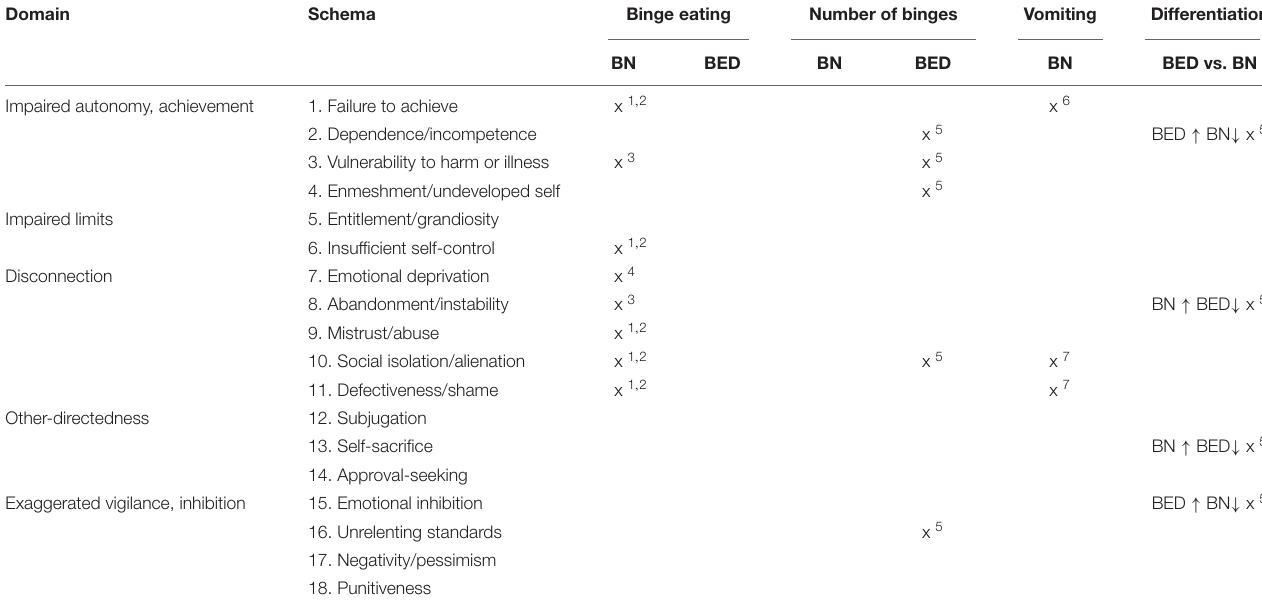
TABLE 2 | Overview of findings indicating a relation between eating disturbances and early maladaptive schemas separated for different binge eating disorder subtypes. Domain